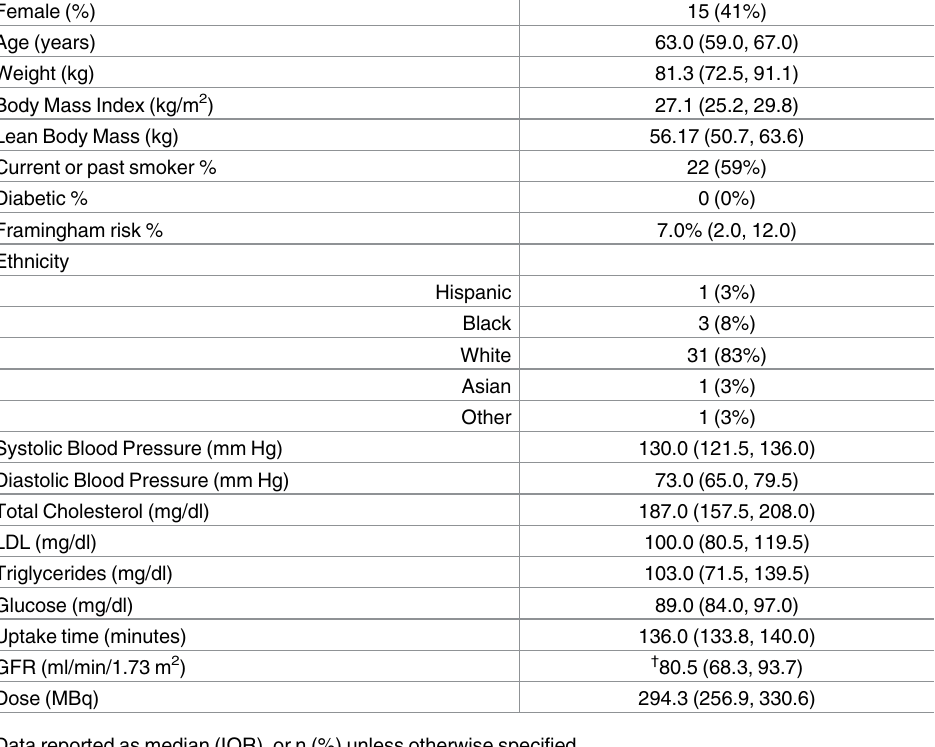
Table 1. Subject characteristics (n = 37) and imaging parameters.